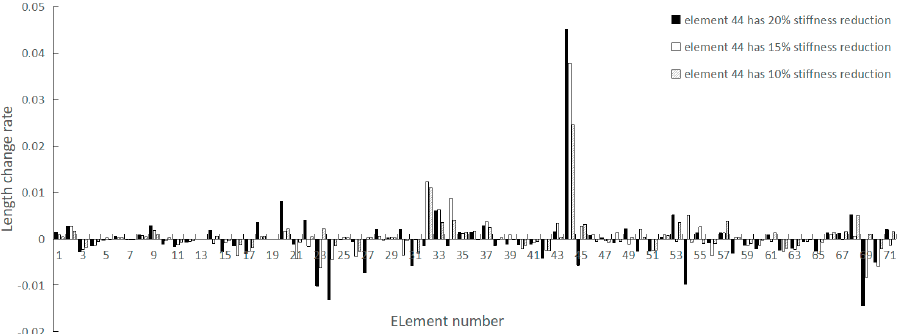
Figure 12. Length change rate of element obtained from the static data with an added 5% noise (element 44 has 20%, 15%, and 10% stiffness reductions).